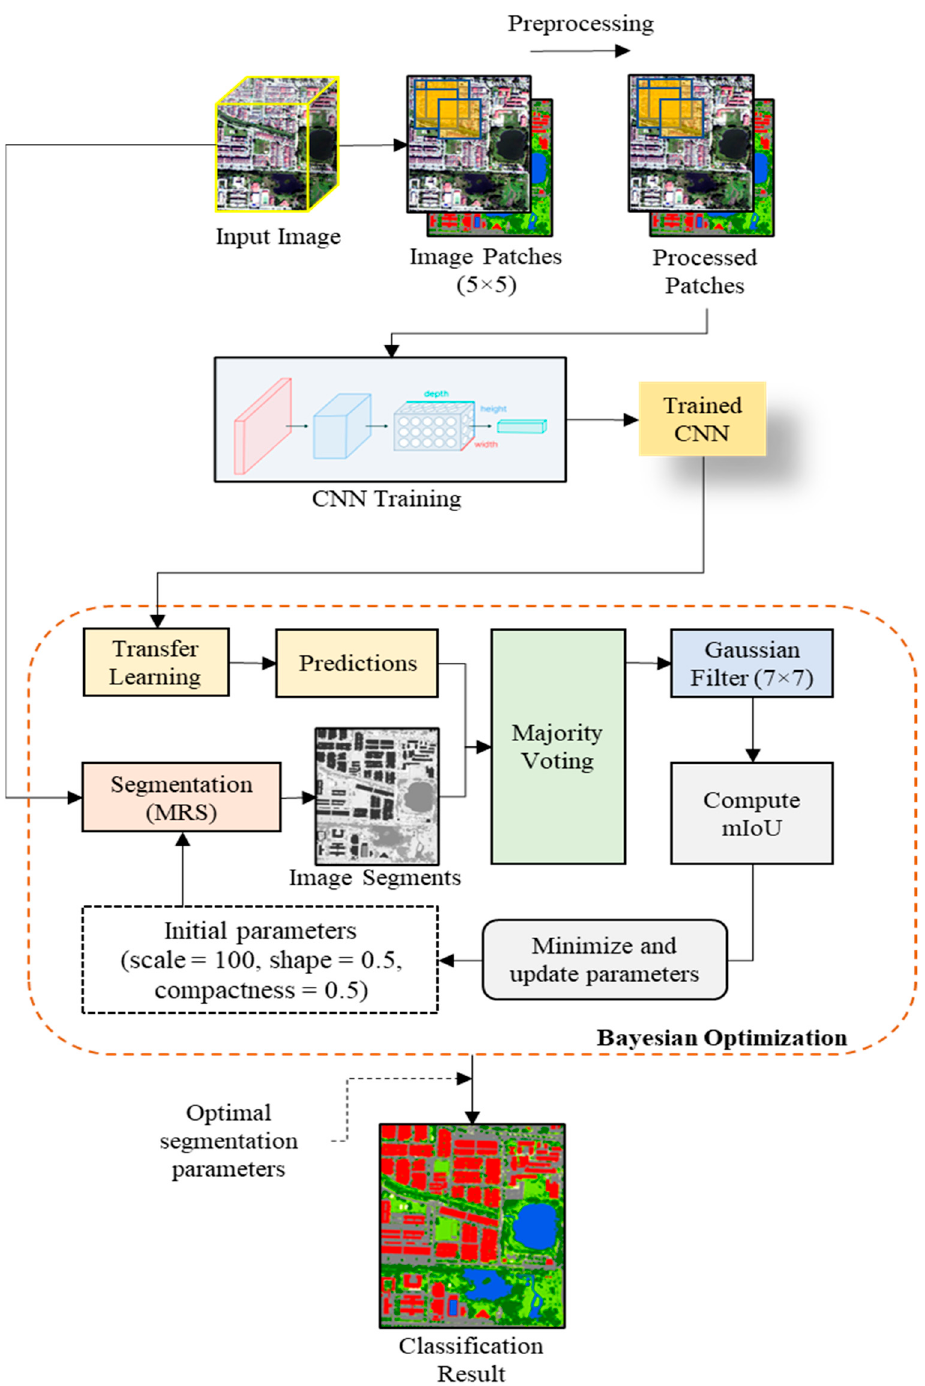
Figure 4. Workflow of the Bayesian optimization procedure to jointly optimize segmentation and feature learning for image classification.